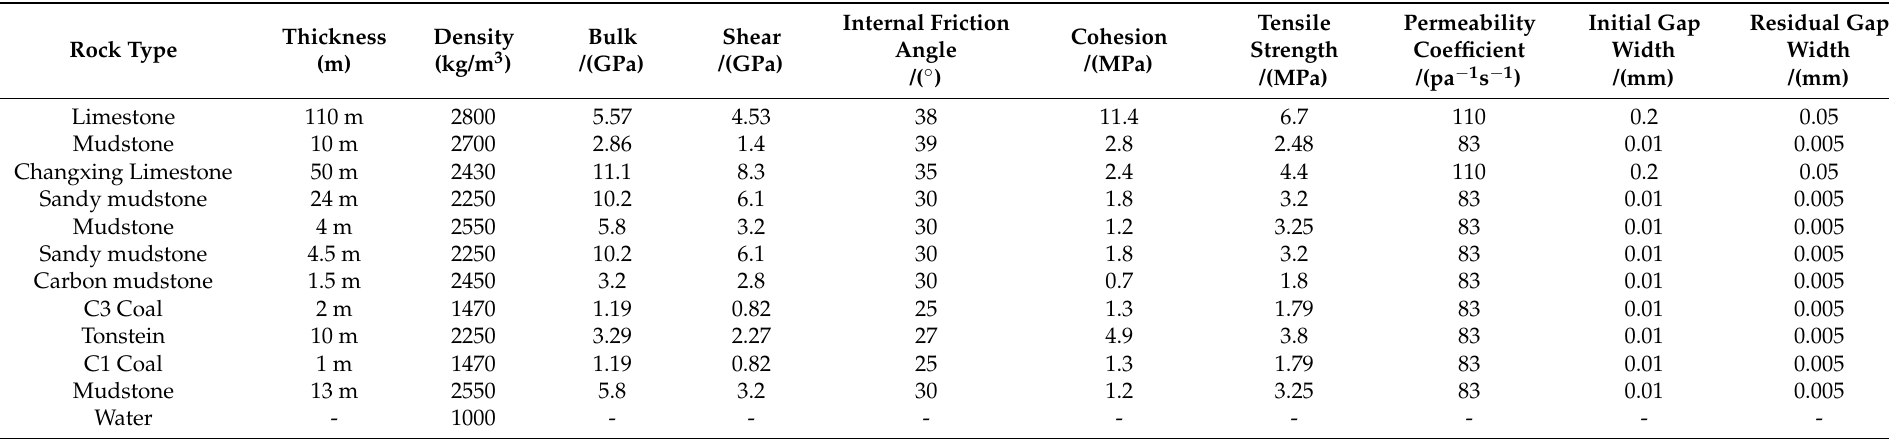
Table 1. Physical, mechanical and hydraulic parameters of coal and rock